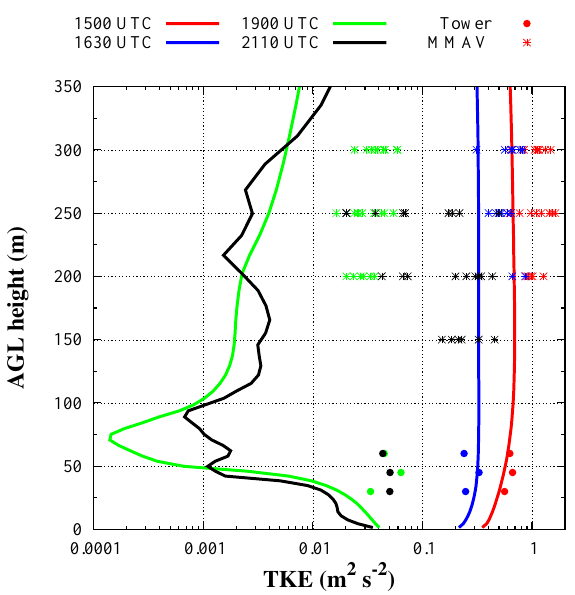
Figure 6. Vertical profiles of the simulated TKE (in lines) at differ- ent instants during the M 2 AV flights (see legend). 60m tower (in dots) and M 2 AV (in asterisk) observations are also included. Note the logarithmic scale on the x axis. For M 2 AV, σ 2 u = σ 2 v is assumed.